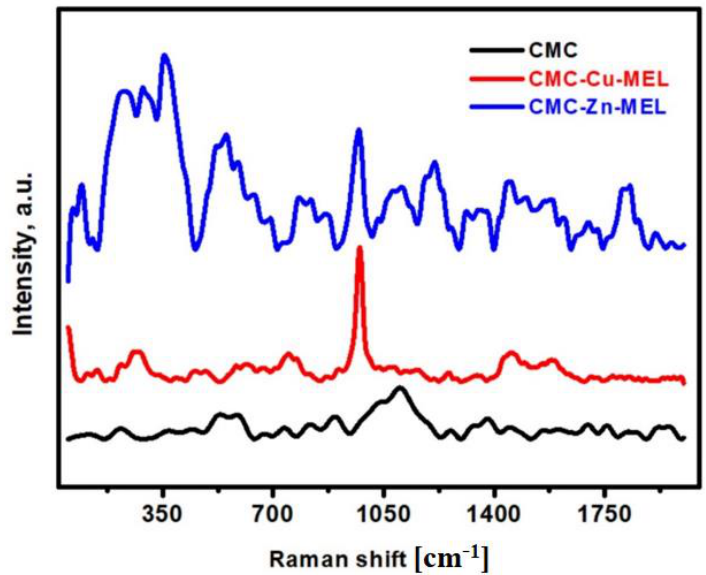
Figure 7. Raman spectroscopy analysis of CMC, CMC-Cu-MEL, and CMC-Zn-MEL.